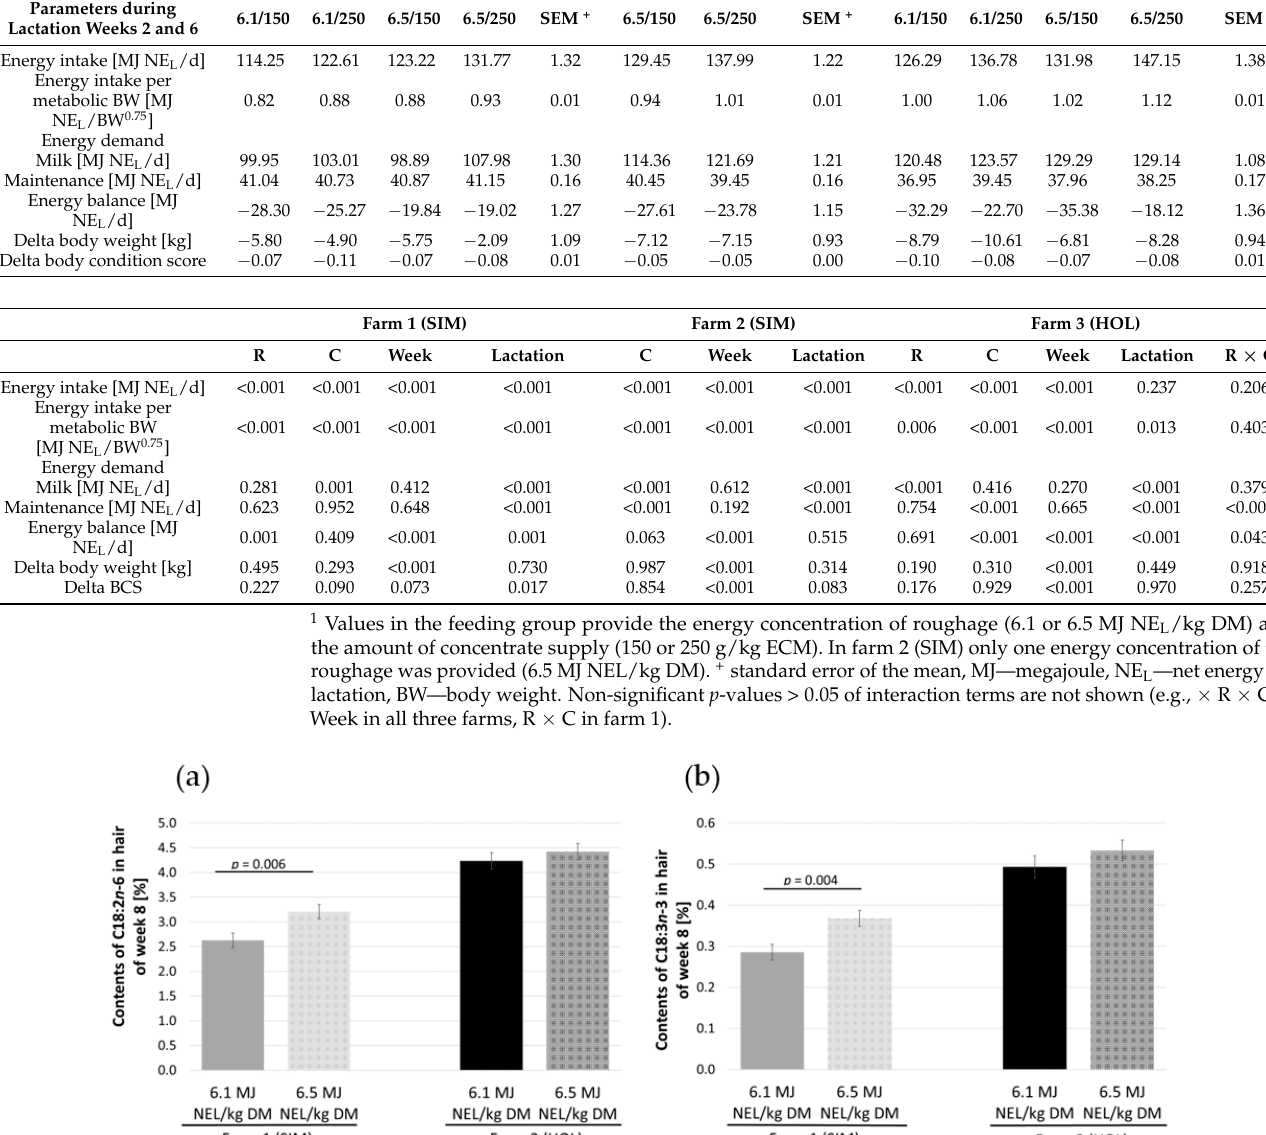
Figure 2. Contents of ( a ) C18:2 n -6 and ( b ) C18:3 n -3 in the hair of lactation week 8 based on moderate (6.1 MJ NE L /kg DM) and high (6.5 MJ NE L /kg DM) energy concentration of the roughage in farms 1 (SIM) and 3 (HOL). In farm 2 (SIM), the energy concentration of the roughage was always the same (6.5 MJ NE L /kg DM).